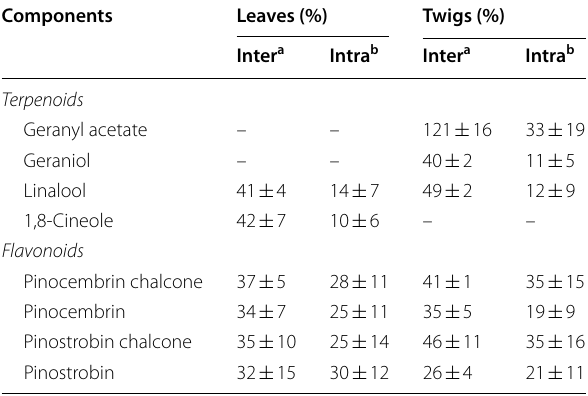
Table 1 Mean values of the inter- and intra-individual coefficient of variation for the major terpenoids and flavonoids Components